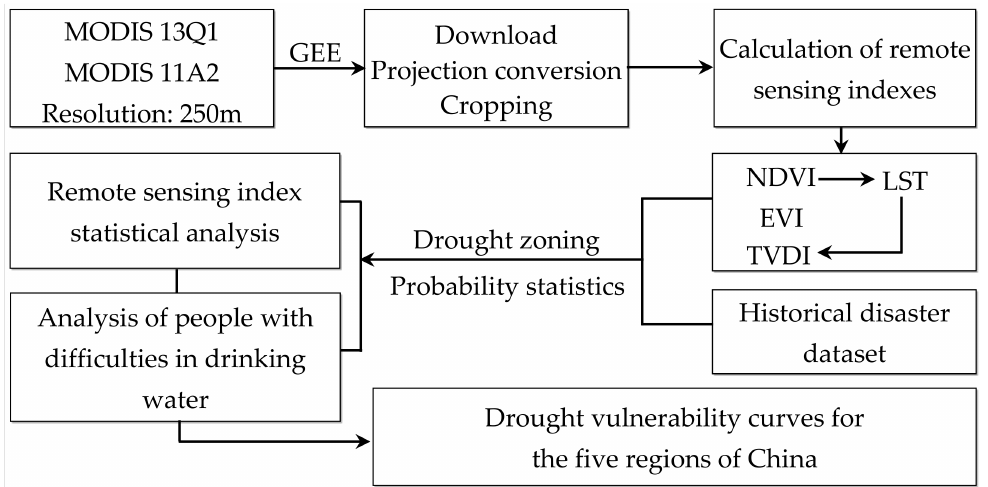
Figure 2. Flow chart of the methodology of this